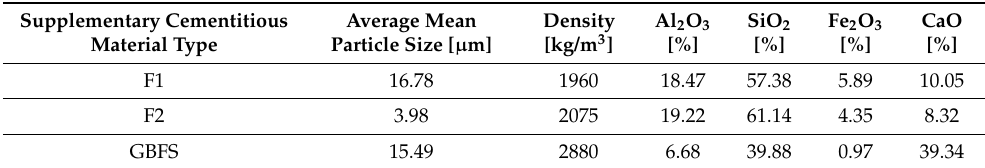
Table 1. The particle size distribution, density and chemical composition of FA and